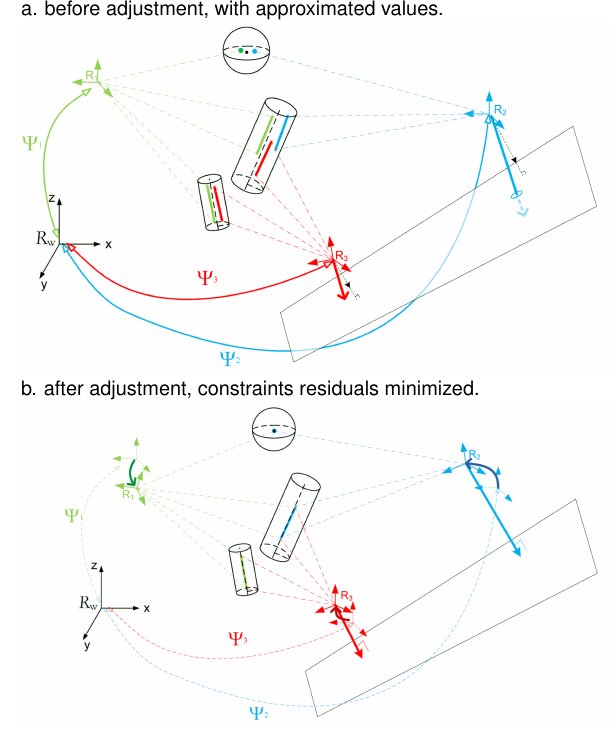
Figure 2: Principle of the current feature-based registration. In the scene: 3 stations, 2 lines, 1 point and 1